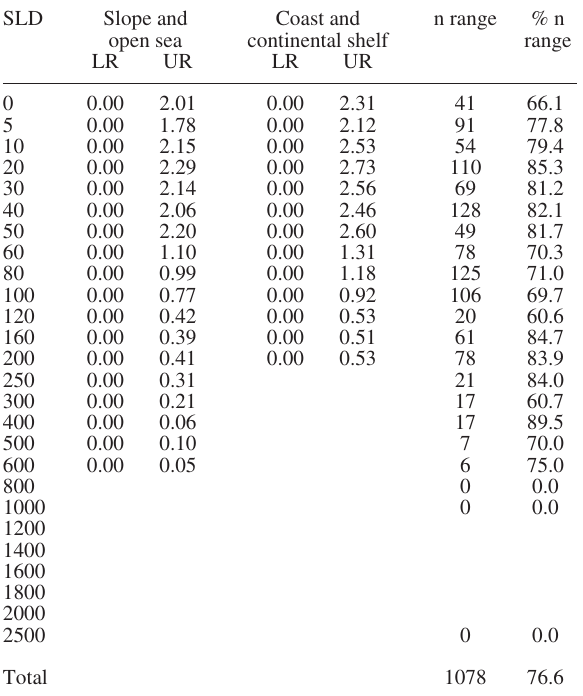
Table 18. – Chl a concentration ( m g l -1 ) ranges in the NW Mediter- ranean Sea in mixed water columns (stratification coefficient = 1). Headers as in Table 7. SLD